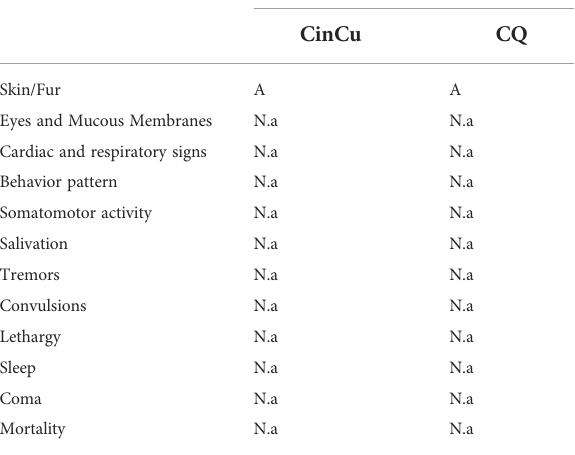
TABLE 3 Toxicity signals after treatment with CinCu and chloroquine (CQ) at 300 mg/kg dose. Parameters observed